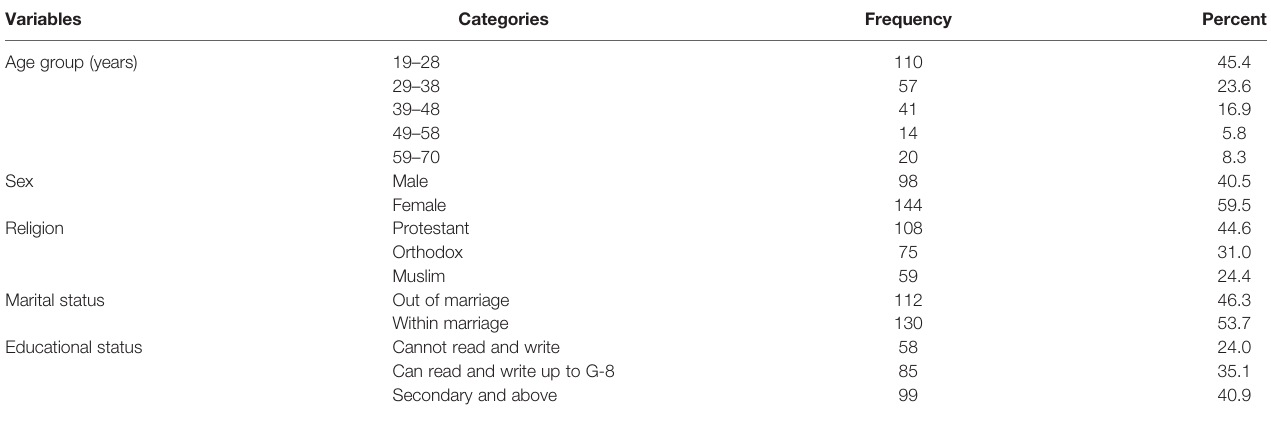
TABLE 1 | Socio-demographic characteristics of type 1 diabetes patients at metu karl heinz referral hospital in ethiopia.